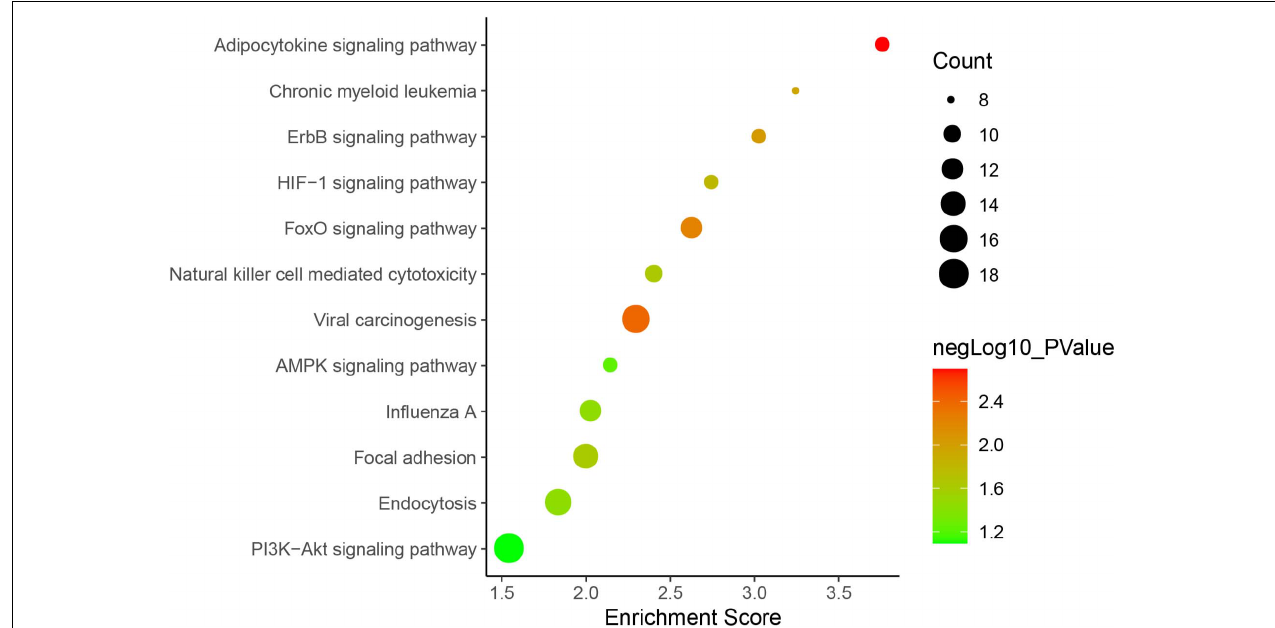
FIGURE 6 | KEGG pathways involved in lncRNA-mRNA interaction network in SAPHO syndrome. A higher enrichment score and a lower p -value indicate stronger pathway enrichments. The top 10 significantly enriched terms of biological process, cellular component and molecular function in GO analysis are shown in Figure 7 . Specifically, genes in the lncRNA-mRNA interaction network were enriched for terms related to production and function of miRNAs, indicating that DE lncRNAs may also function by regulating miRNAs to influence the expression of targeted